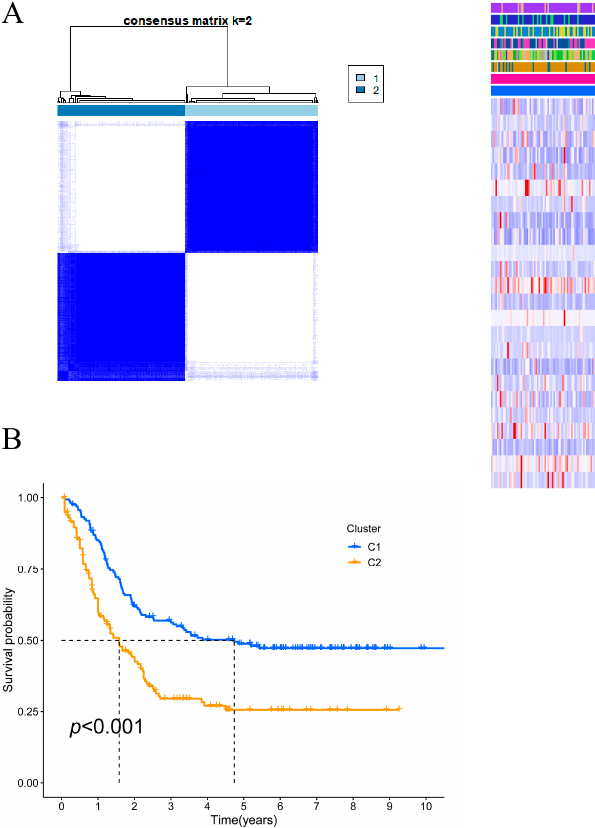
Figure 2. AML clustering based on the differentially expressed pyroptosis-related genes. ( A ) All AML patients with available survival data from the TCGA-TARGET cohort were divided into two clusters according to the consensus clustering matrix (k = 2). ( B ) Kaplan–Meier overall survival curves of the two clusters. C1, Cluster1; C2, Cluster2. ( C ) Heatmap and clinical features of the two clusters. * p < 0.05; *** p <